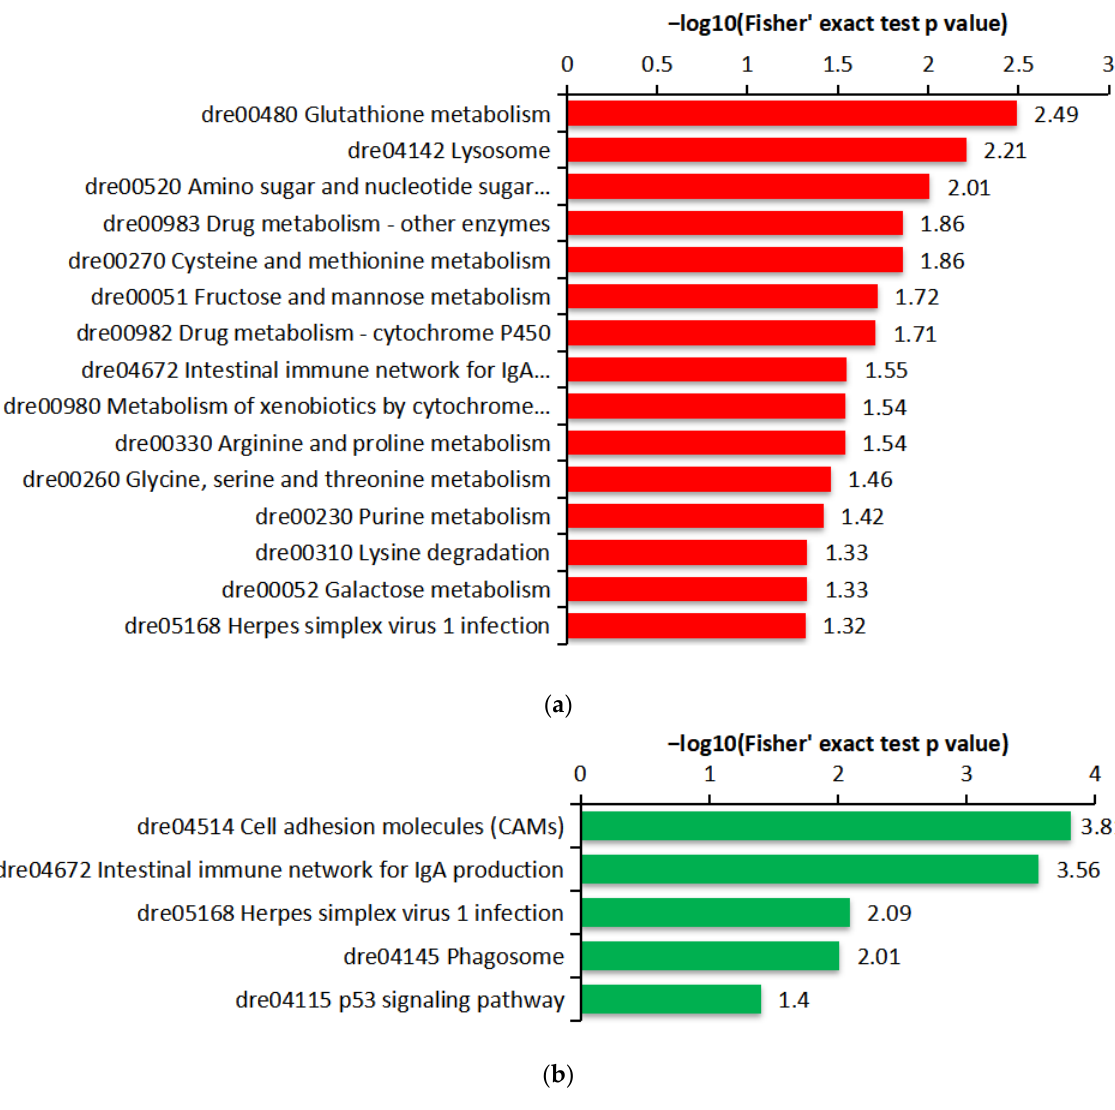
Table 2. The result of the DEP detection by PRM.